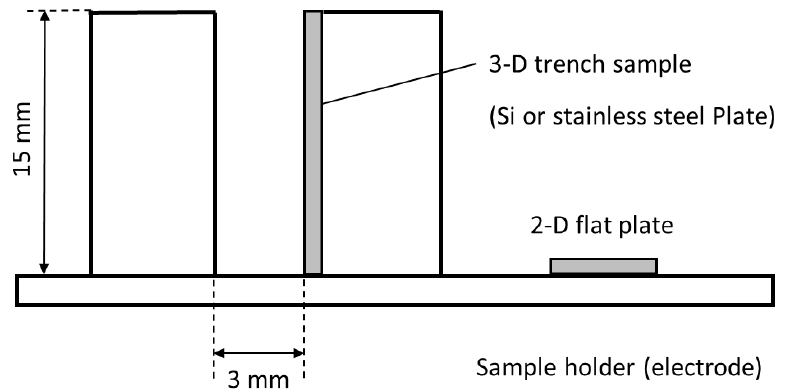
Figure 3. Schematic diagram of trench sidewall and 2-dimensional flat samples.